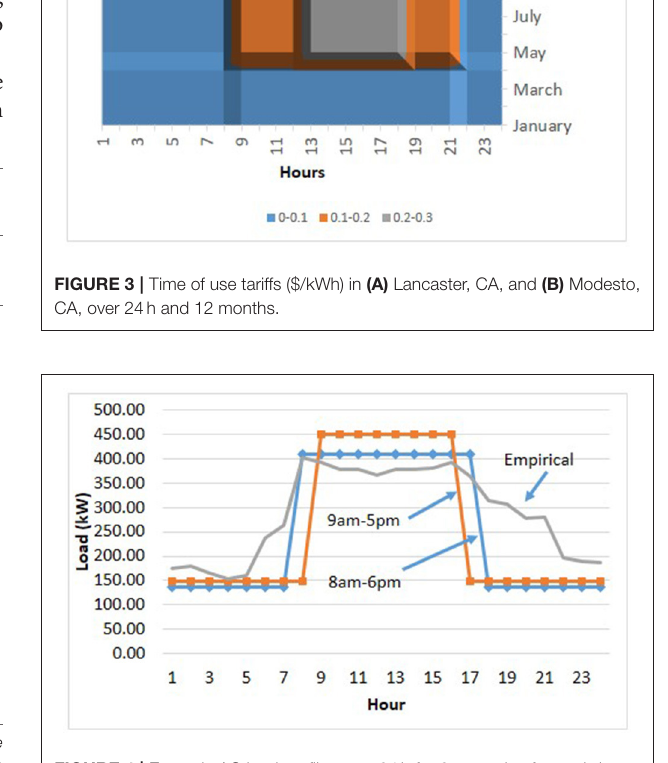
FIGURE 4 | Example AC load profiles over 24h for 3 scenarios for workdays in June. The total annual load is scaled to be the same for each